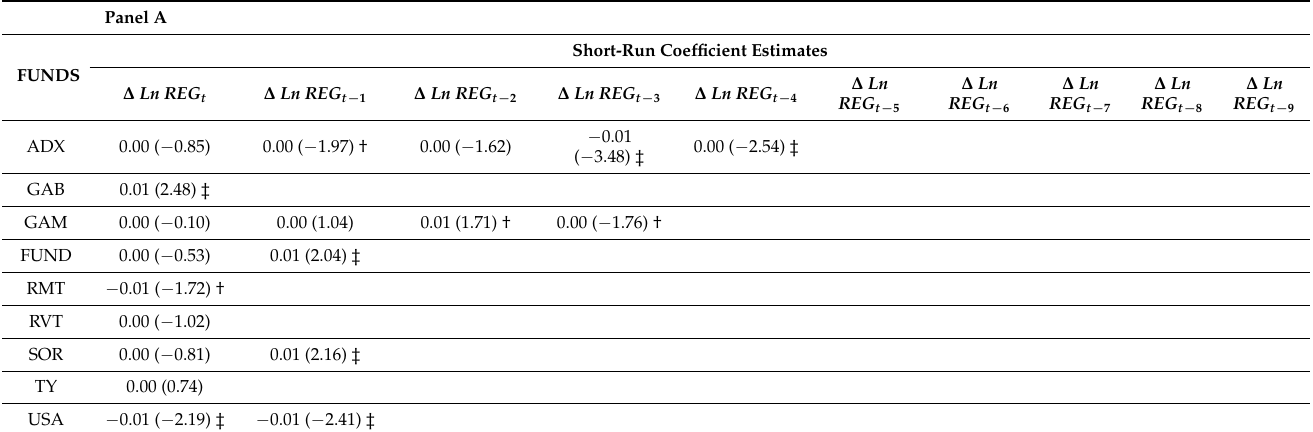
Table 9. Short-Run Coefficient Estimates—Linear ARDL—Model P = f (NAV,